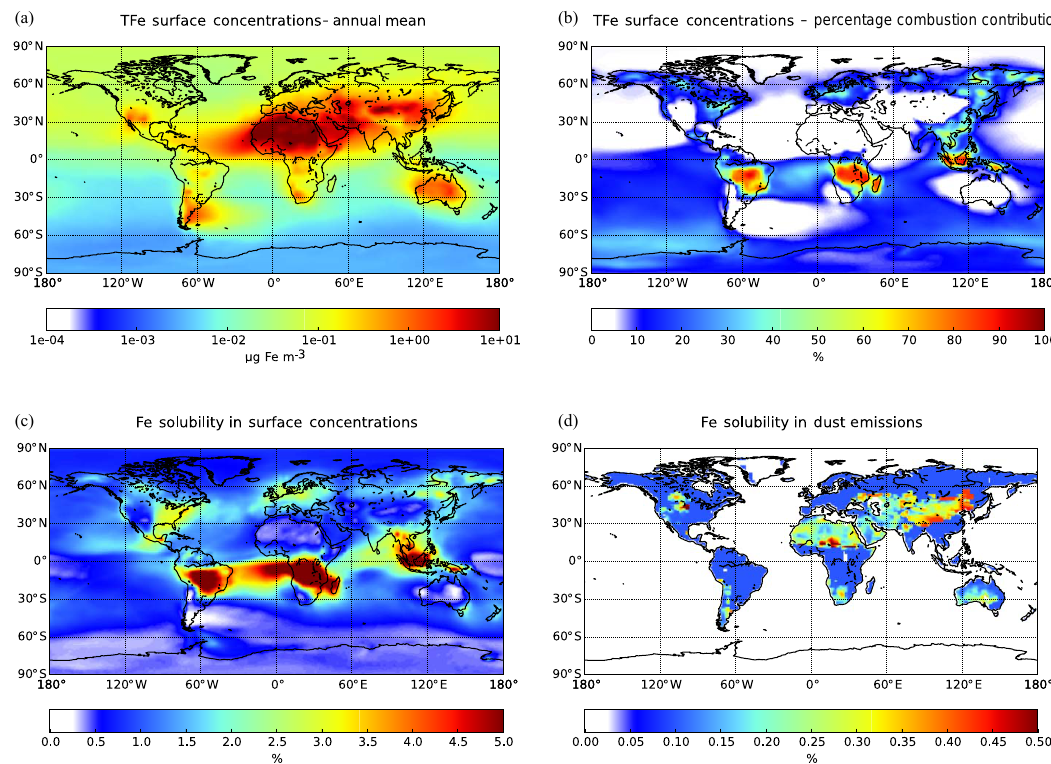
Figure 2. Ensemble model results for annual mean (a) surface TFe concentration (µgm − 3 ), (b) the percentage contribution of Fe-containing combustion aerosols, (c) the Fe solubility (%) in surface TFe concentration and (d) the initial solubility (%) in Fe-containing dust